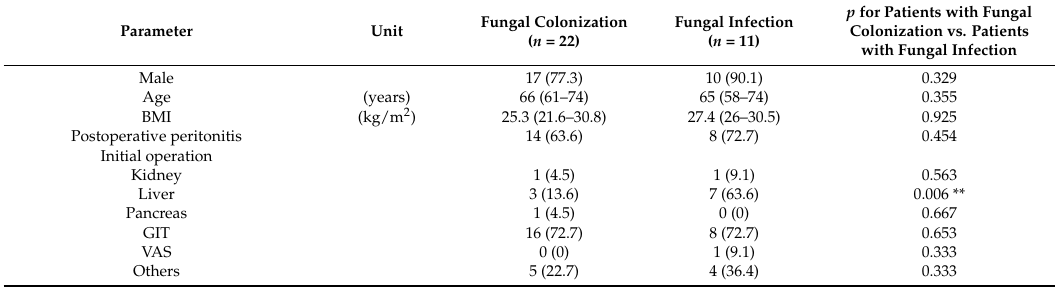
p for Patients with Fungal Colonization vs.